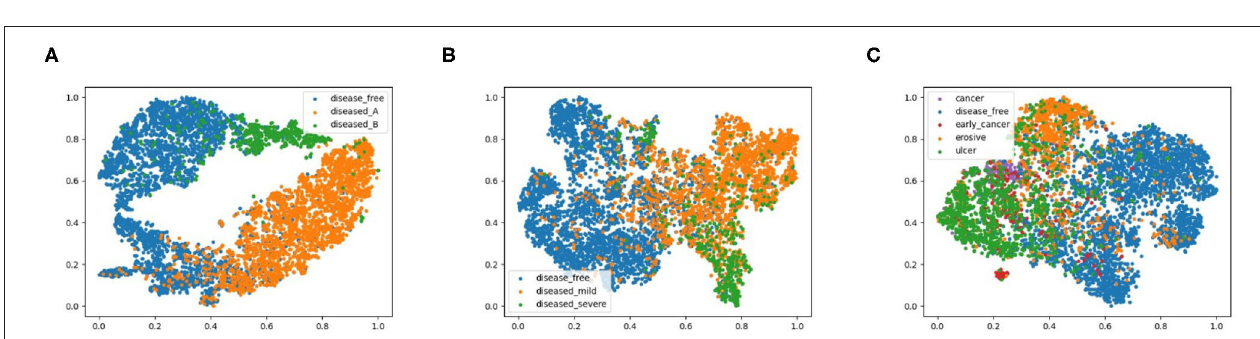
FIGURE 7 | 2D PCA analysis scatter for image classification experiments, (A) shows the 2-class experiments, and we also plot the disease from different data source with different colors, (B,C) represent the 3-class and 5-class